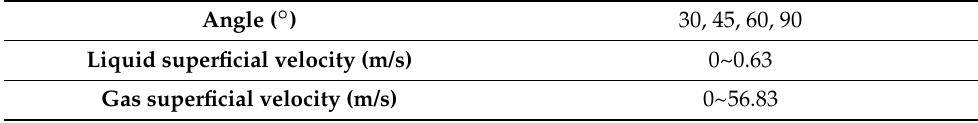
Table 1. Range of experimental